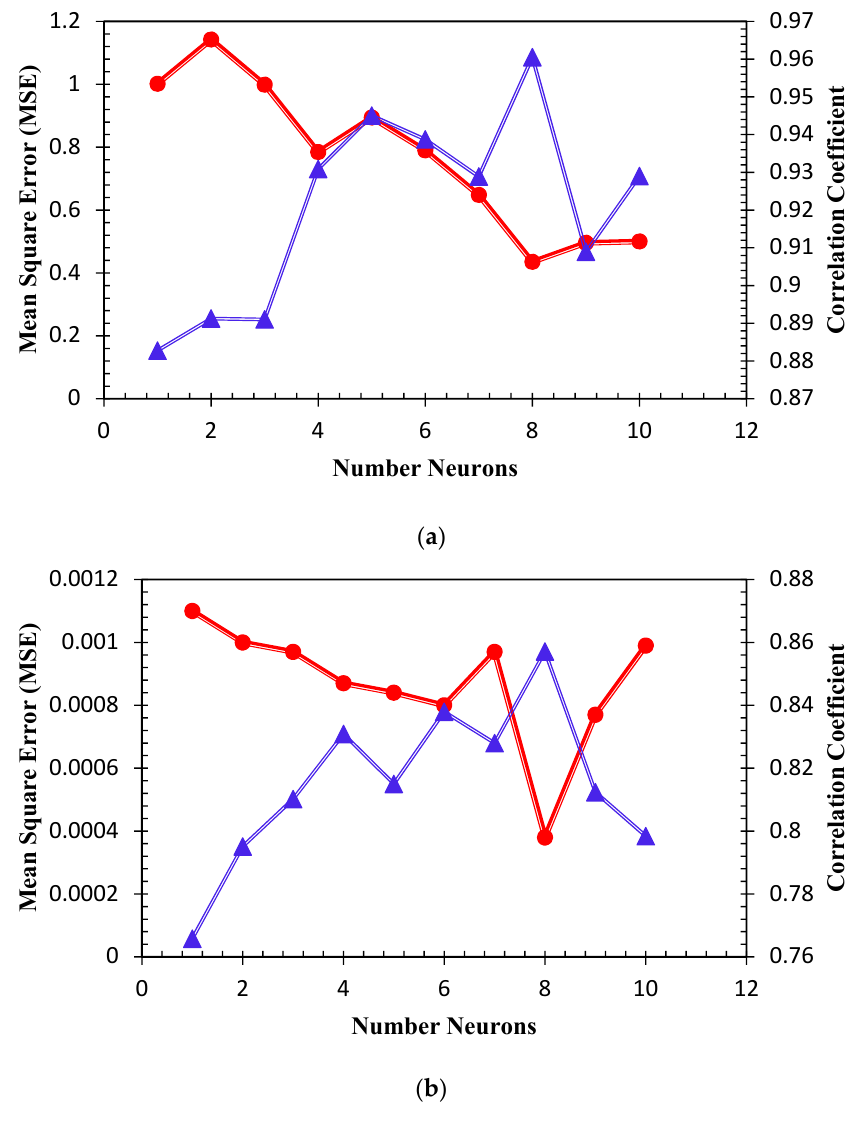
Figure 3. Effect of the number of hidden neurons on the performance of the PSO-ANN model in terms of R 2 and MSE values for ( a ) viscosity ( b ) thermal conductivity.